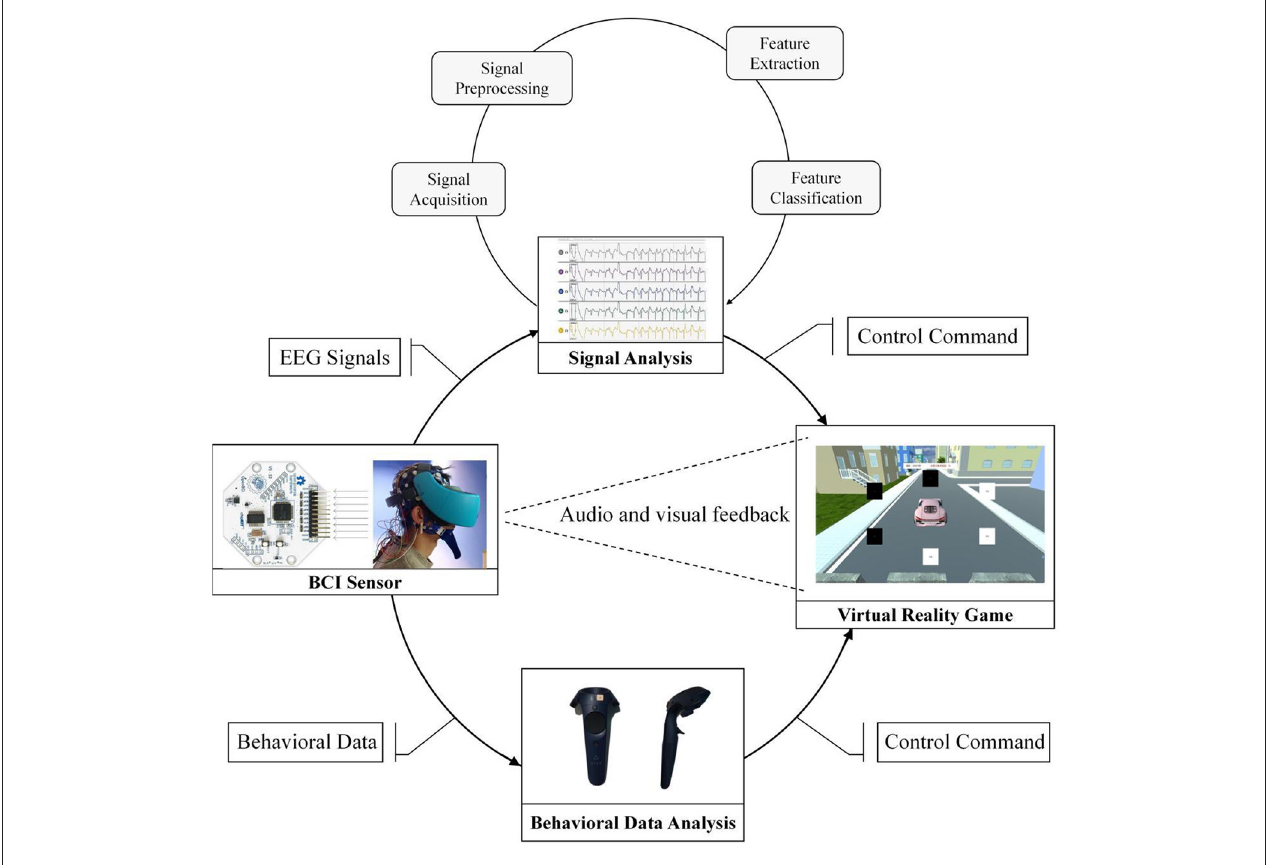
FIGURE 1 | Diagram of the rehabilitation strategy based on